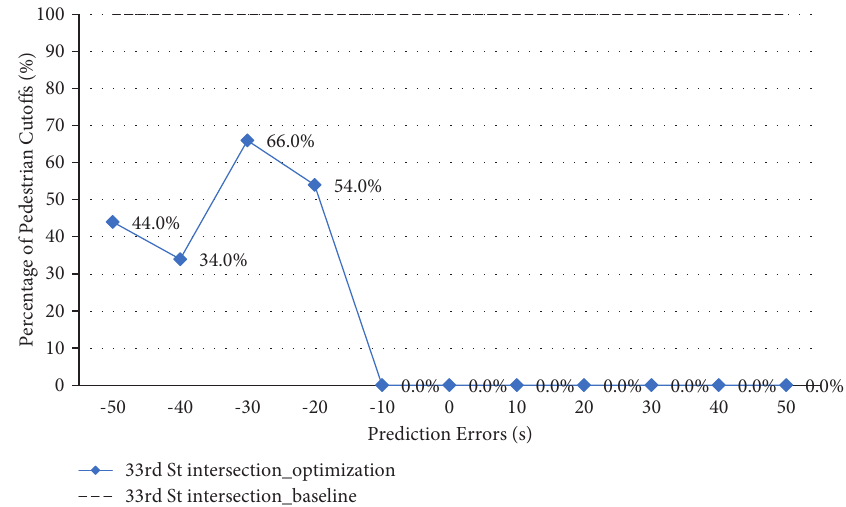
Figure 9: Percentages of pedestrian phase cutoffs in relation to prediction errors at 33rd Street intersection.